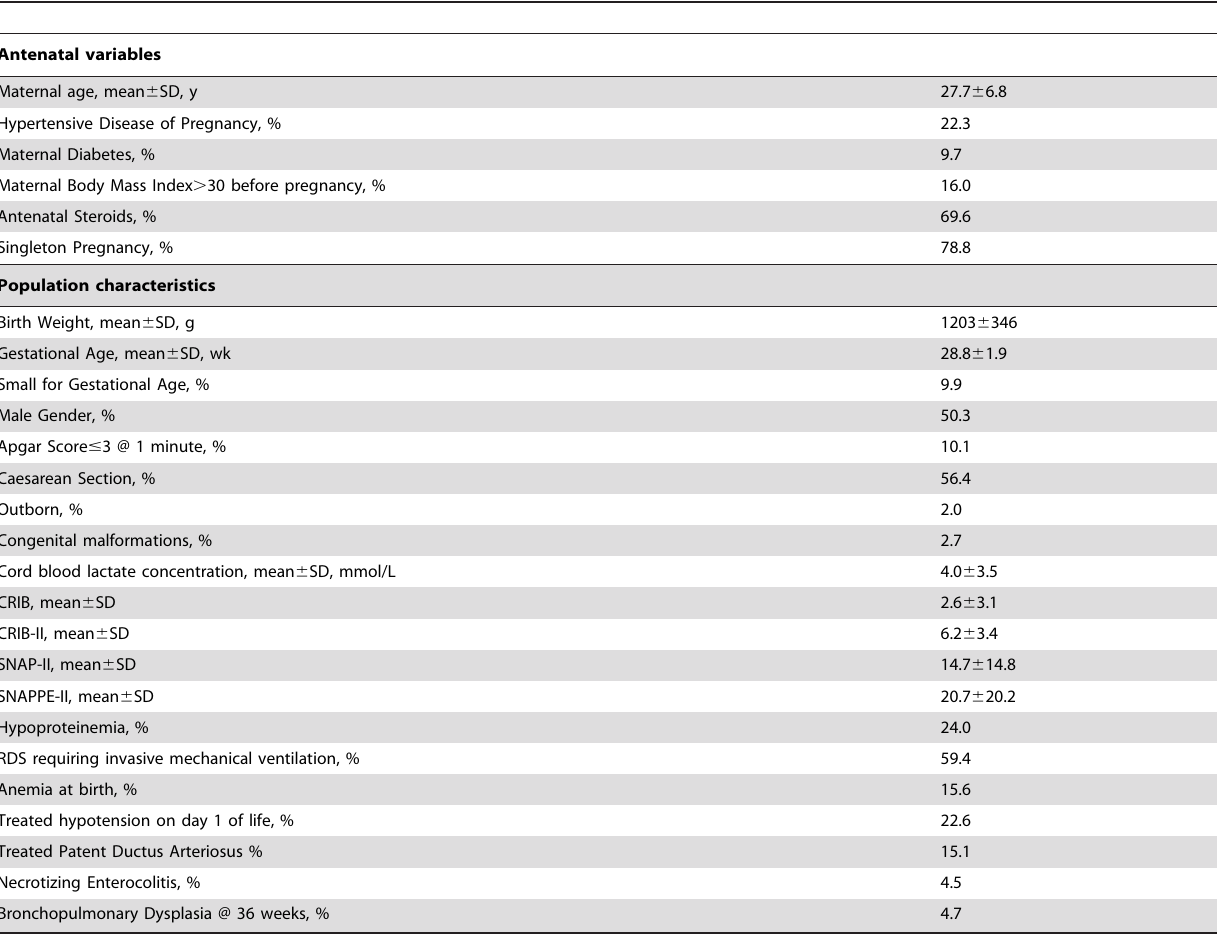
Table 1. Population characteristics (n= 761 preterm infants , 32 weeks